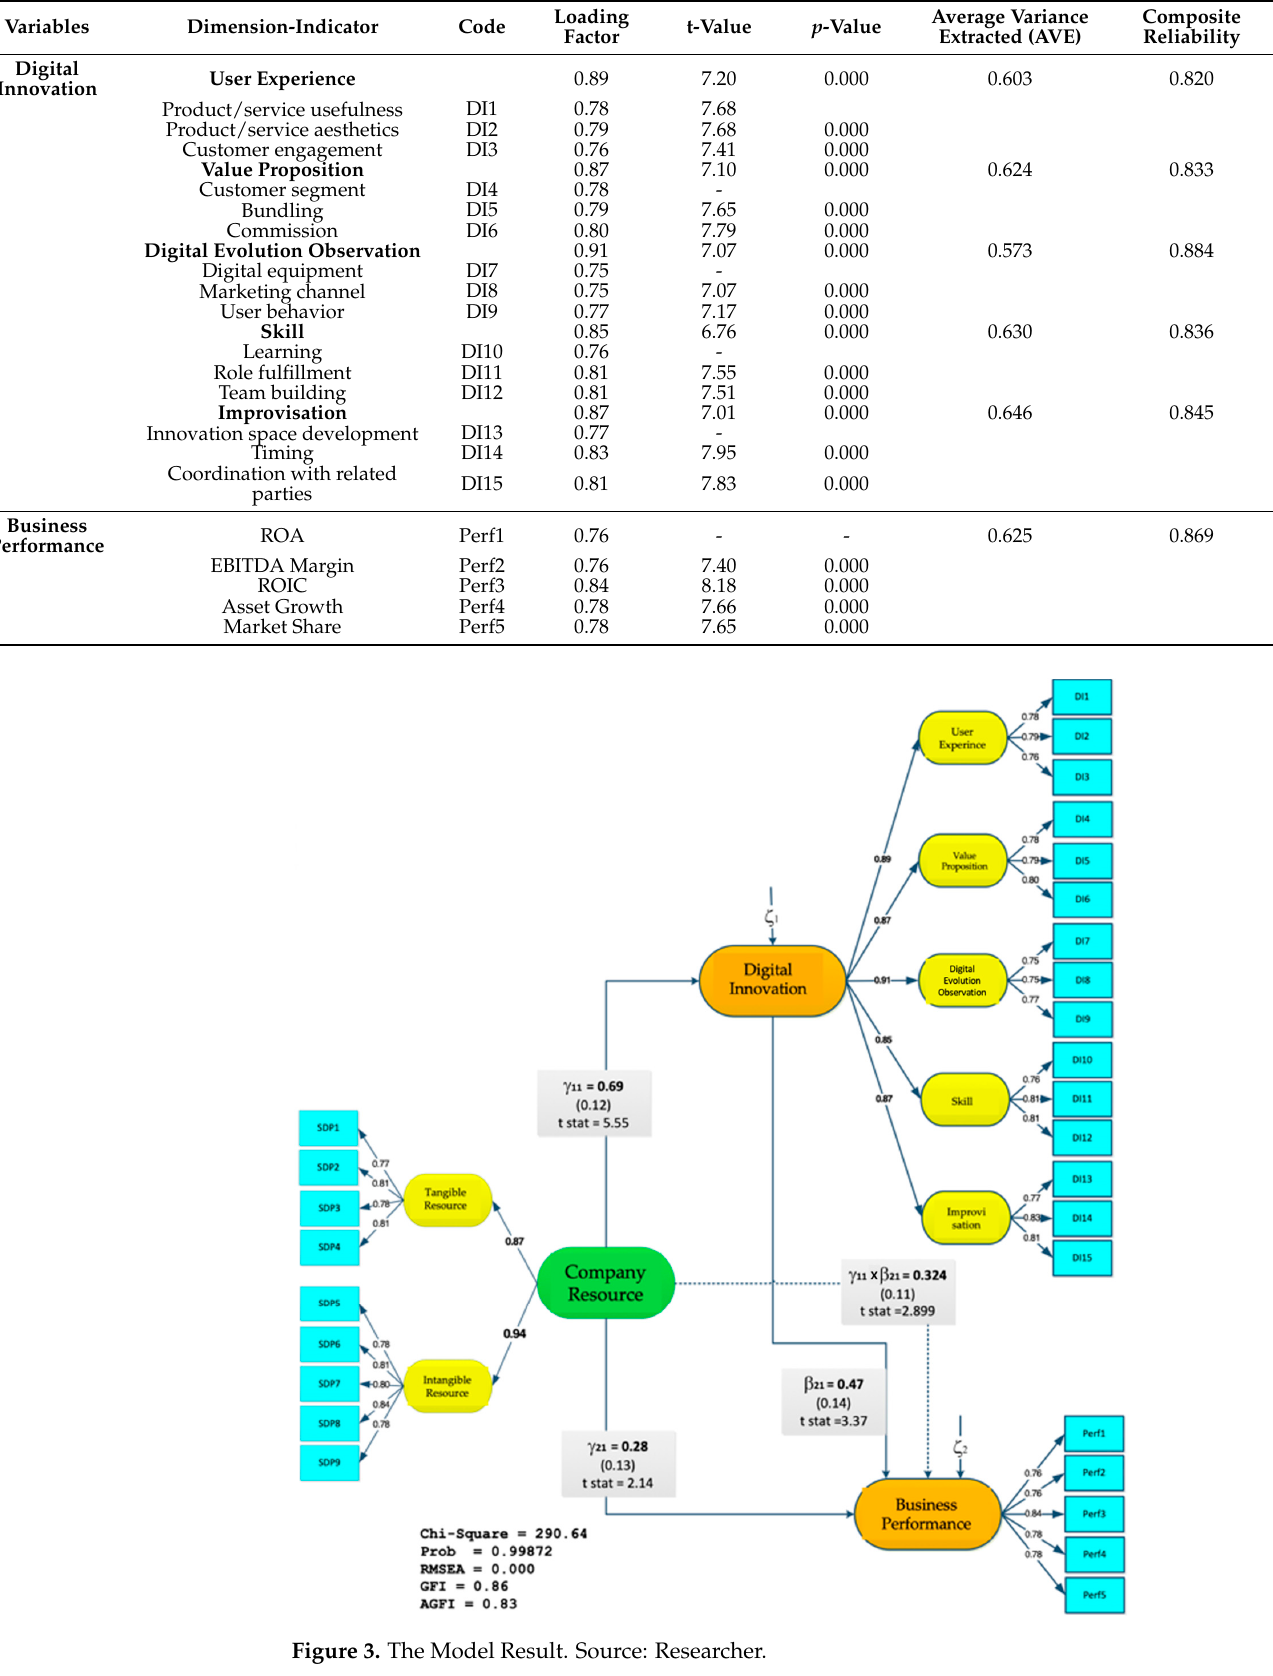
Table 5. Hypothesis testing results, Source: Researcher.